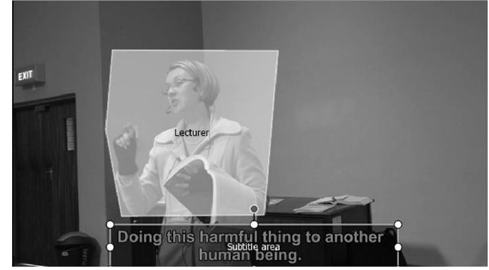
Figure 1. Screenshot from video showing marked areas of interest